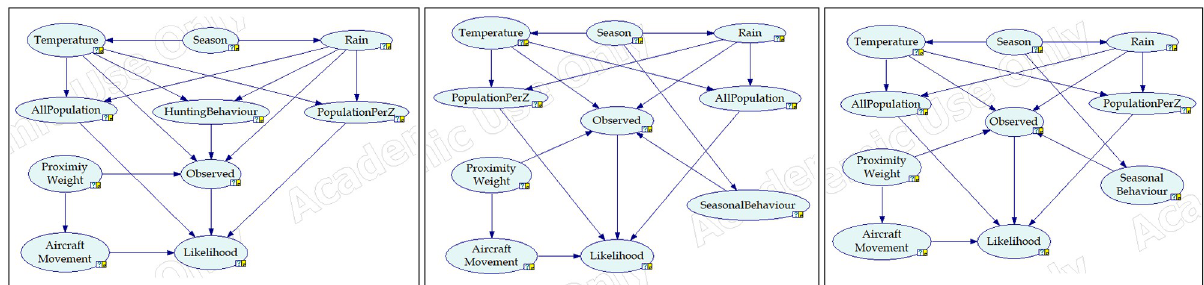
Fig 1. BNM configuration for Nankeen Kestrel, Straw-necked Ibis, and Cattle Egret. (a) BNM design for Nankeen Kestrel, (b) BNM design for Straw-necked Ibis, (c) BNM design for Cattle Egret.